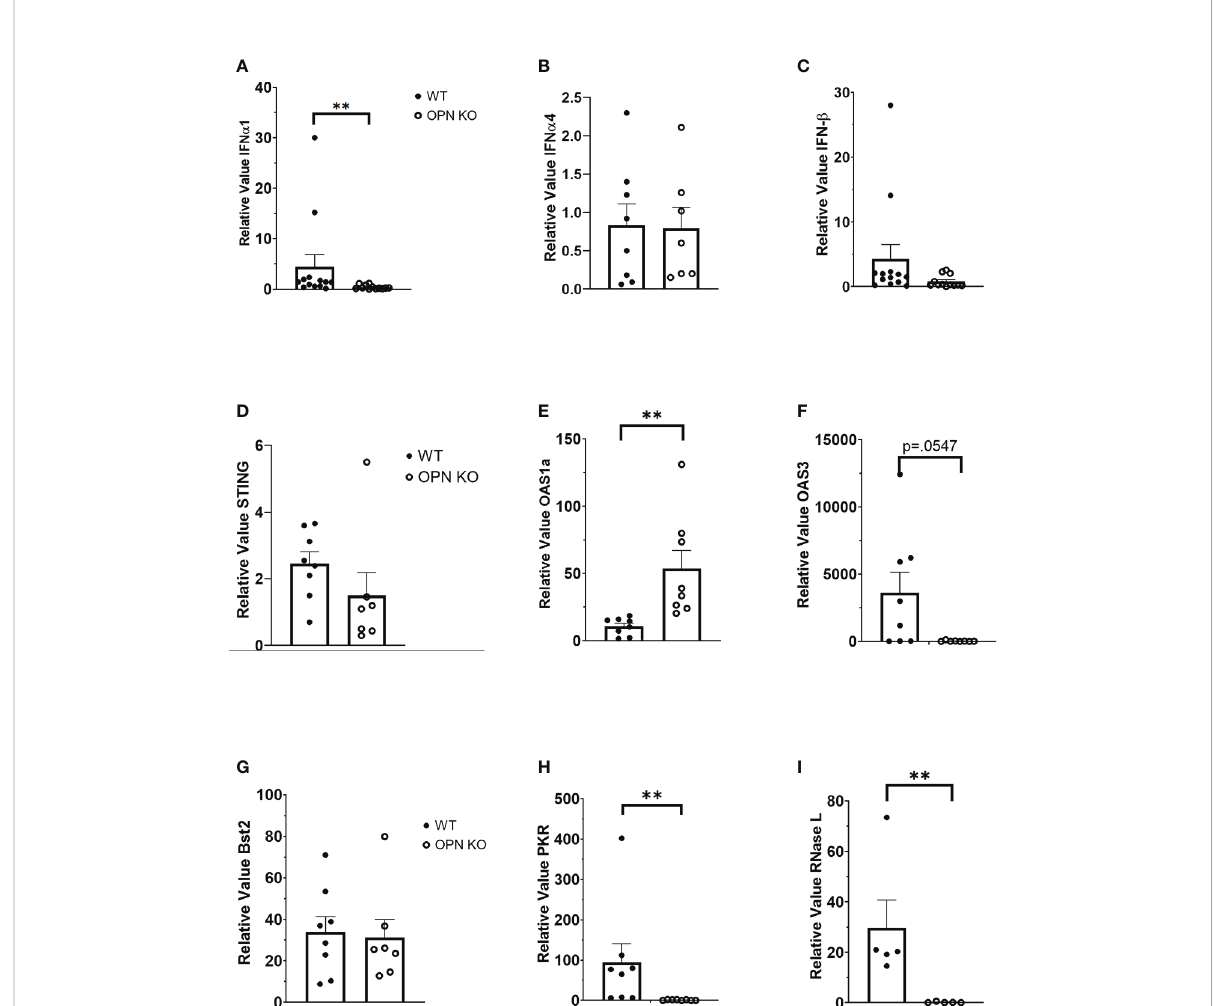
FIGURE 2 Type I IFN expression is suppressed in the cornea of HSV-1-infected OPN KO mice. WT and OPN KO male and female mice (n=5-13/group) were infected with HSV-1 (350 PFU/cornea). At day 3 PI, the mice were exsanguinated, and the corneas were removed and processed for select gene expression including (A) IFN- a 1, (B) IFN- a 4, (C) IFN- b , (D) STING, (E) OAS1a, (F) OAS3, (G) Bst2 (tetherin), (H) PKR and (I) RNase L by real time RT-PCR. The results are expressed in relative value compared to uninfected controls (relative value of 1.0) and expressed as the mean ± SEM, **p < .01 comparing the HSV-1 infected WT to OPN KO mice as determined by the Wilcoxon matched-pairs sign rank